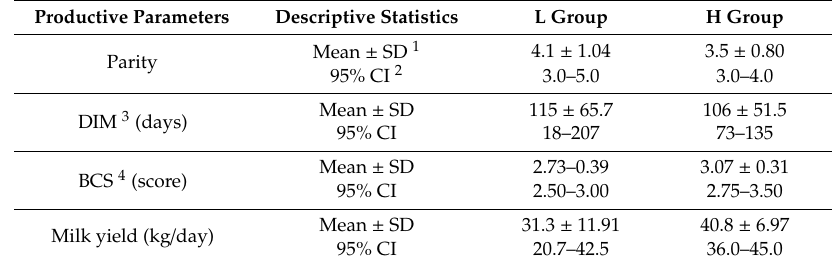
Table 1. Overview of the dairy cows enrolled in the lameness group (L Group) and the healthy group (H